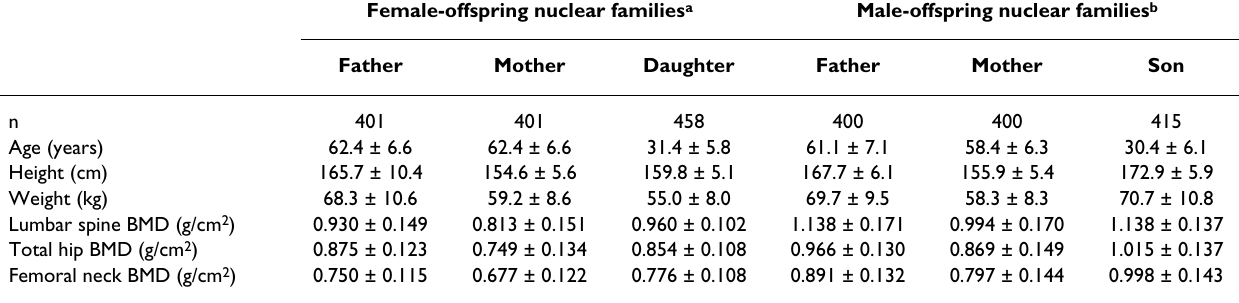
Table 2: Basic characterstics of the study